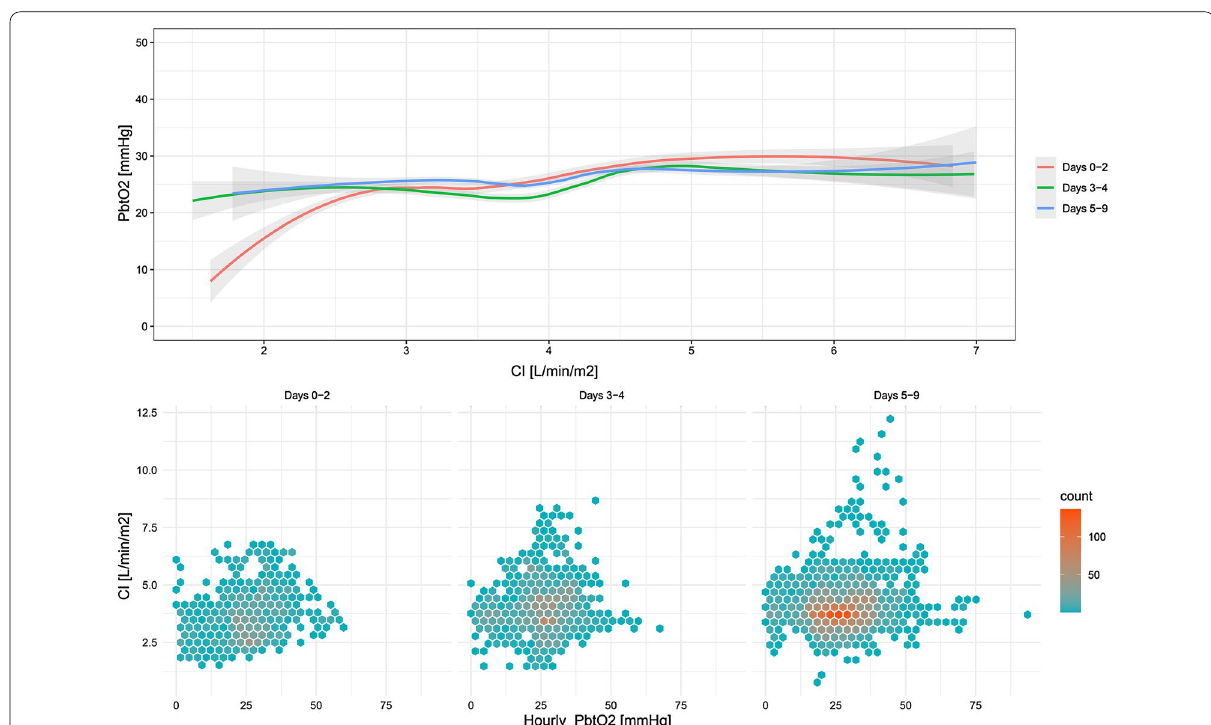
Fig. 3 A positive association between CI and P bt O 2 levels was evident across all time phases. The line represents the local polynomial regression and the gray shades represent 95%